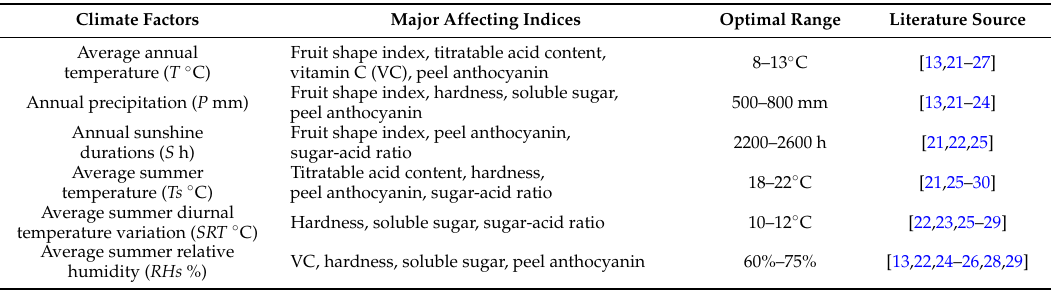
Table 1. Major climate factors affecting apple quality and the optimal indices.